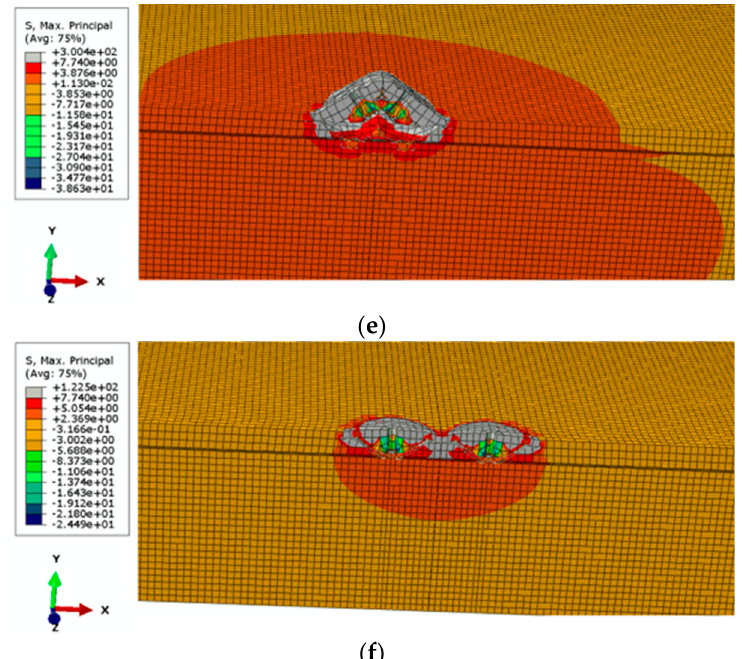
Figure 6. The anchor group effect in cone failure for a group of 2 anchors relative to anchor spacing: ( a – d ) h ef = 100 mm and the spacing s between the holes: ( a ) 100, ( b ) 150, ( c ) 200, d ) 300 mm, ( e,f ) h ef = 50 mm and the spacing s between the holes: ( e ) 50 mm, ( f ) 100 mm.